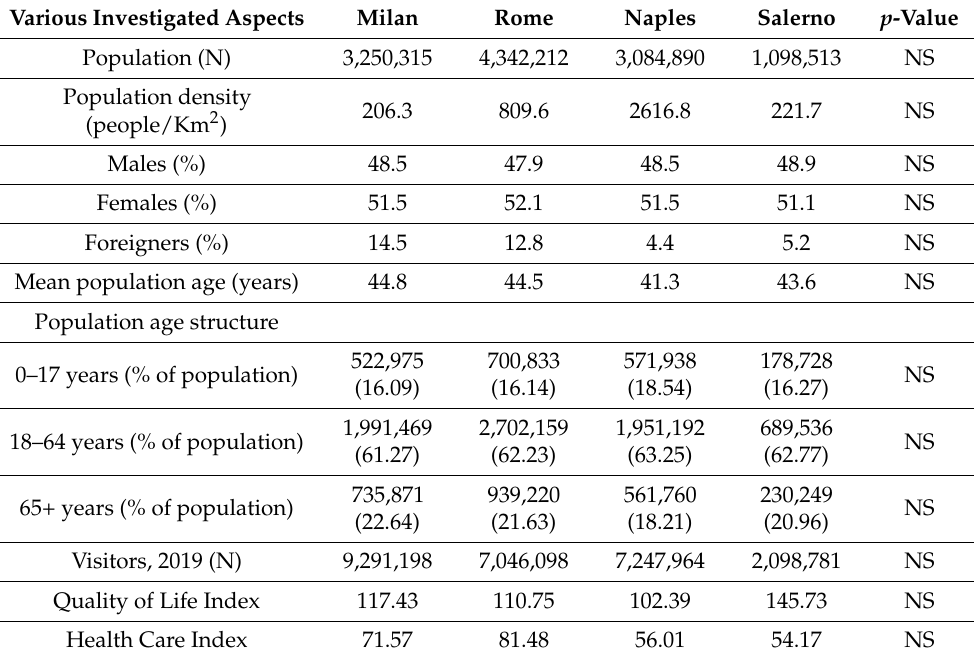
Table 1. Comparisons of demographic and socioeconomic parameters between four high-polluted Italian cities (Milan, Rome, Naples, and Salerno).